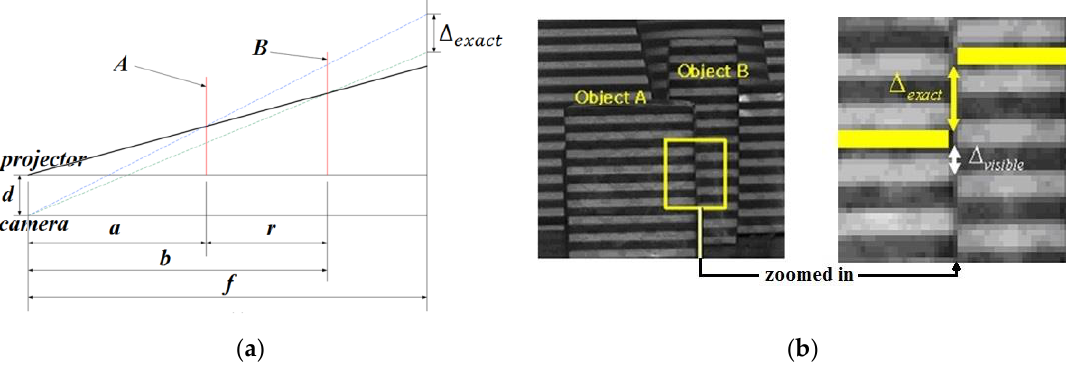
Figure 4. Imaging geometry and pattern offset: ( a ) side view of image geometry; ( b ) ∆ 𝑒𝑥𝑎𝑐𝑡 vs. ∆ 𝑣𝑖𝑠𝑖𝑏𝑙𝑒 .